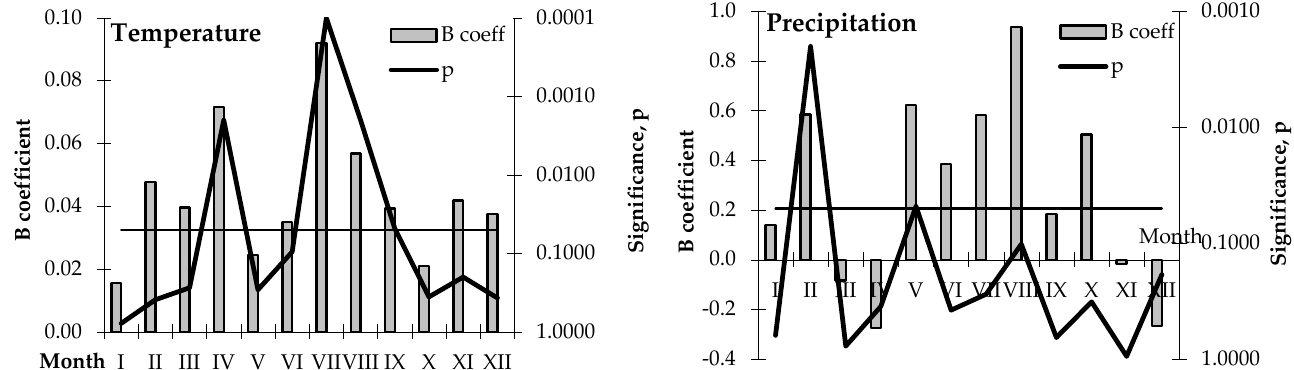
Figure 3. The intensity of changes in monthly meteorological parameters from 1975 to 2013: temperature (left figure) and precipitation (right figure). Higher B regression slope coefficient values indicate a faster increase in monthly meteorological indicators (data received from the Kaunas region meteorology station). Horizontal lines indicate significant changes at the 0.05 level.